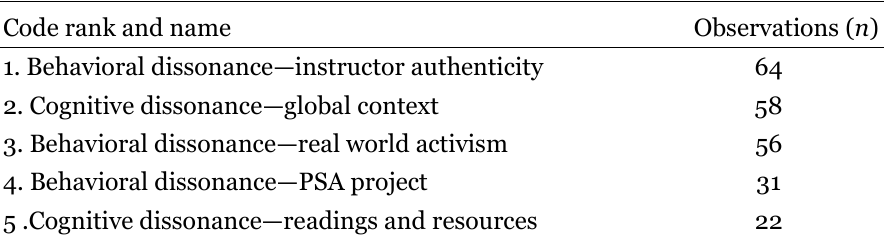
Top Five Instructor Dissonance Codes Observed Code rank and